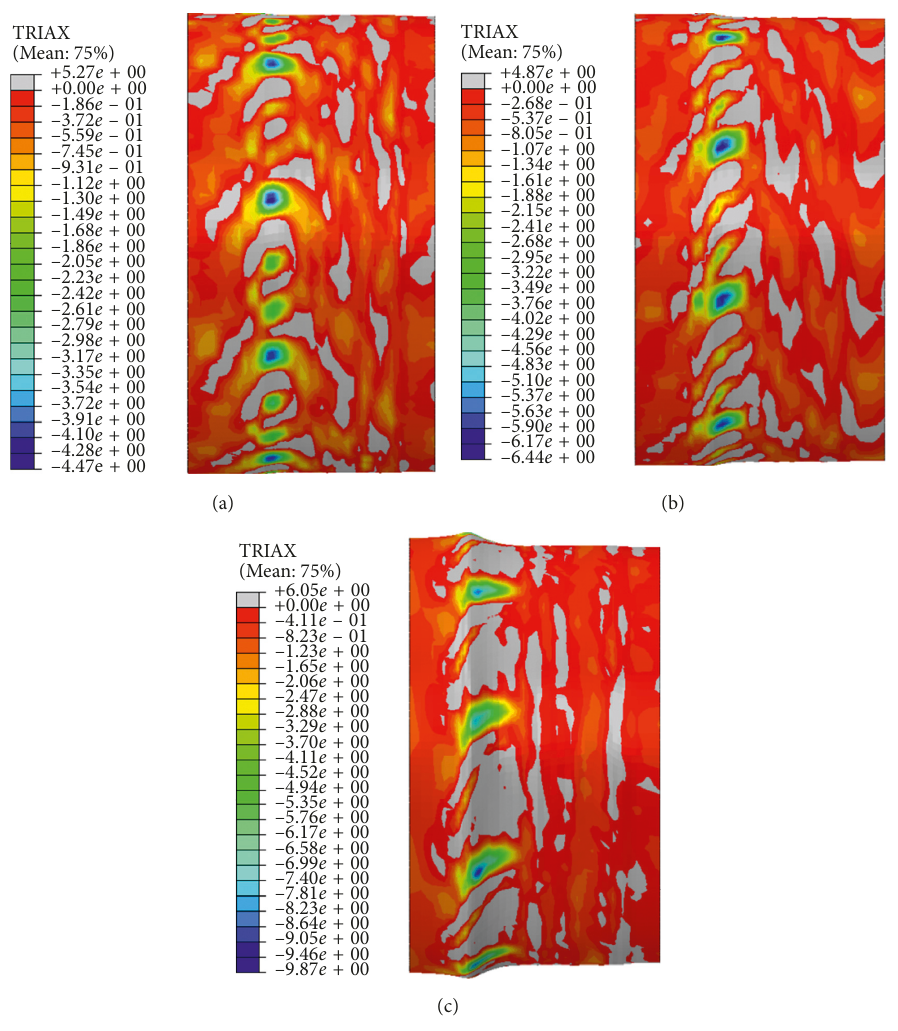
Figure 8: Cloud diagram of relative stress triaxiality for different amounts of thinning. (a) R